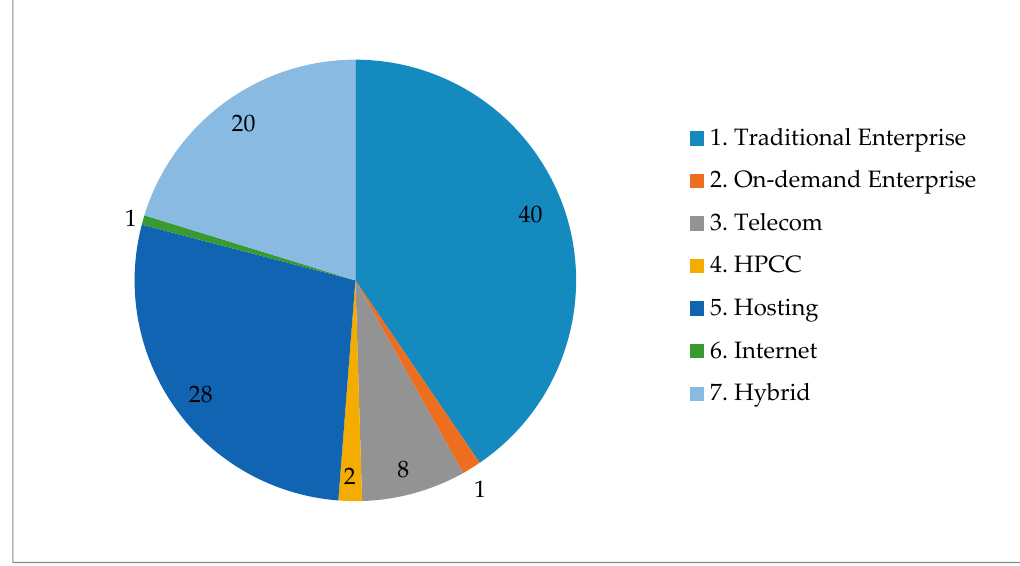
Figure 7. Percentage of each of the seven different sectors.